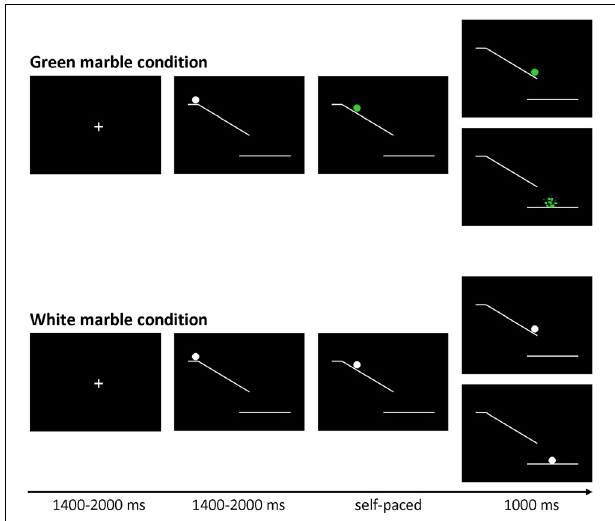
FIGURE 1 | Trial structure of the marble task. Stimuli were presented on a black background. At the beginning of each trial a white marble on top of a ramp was presented. After a variable delay (jittered between 1400 and 2000ms) the marble started to roll down the ramp, and could change color to